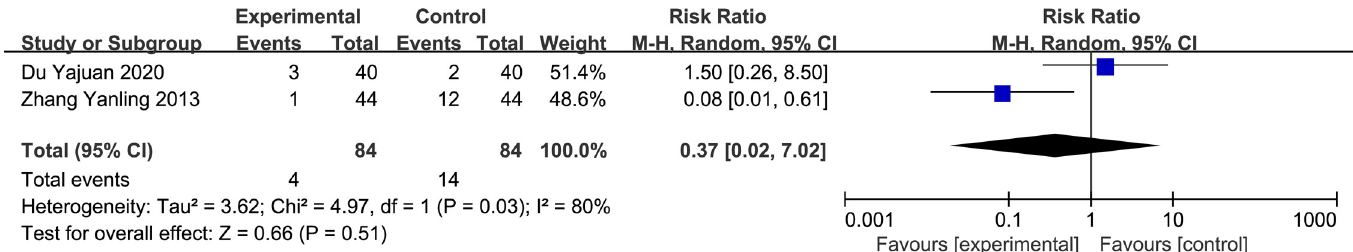
Fig 10. Forest plot of the incidence of dysuria between experimental and control group.